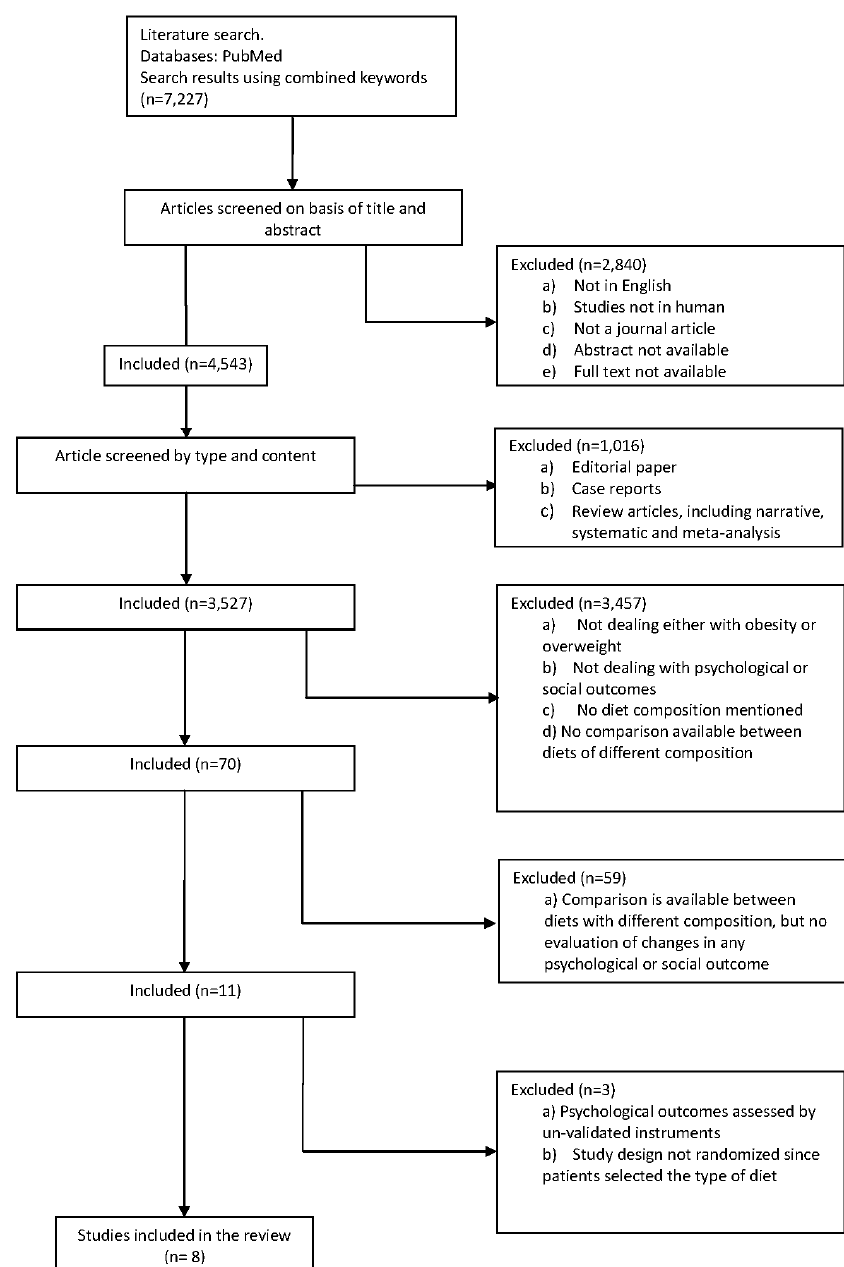
Figure 1. Flowchart summarizing the study selection procedure.